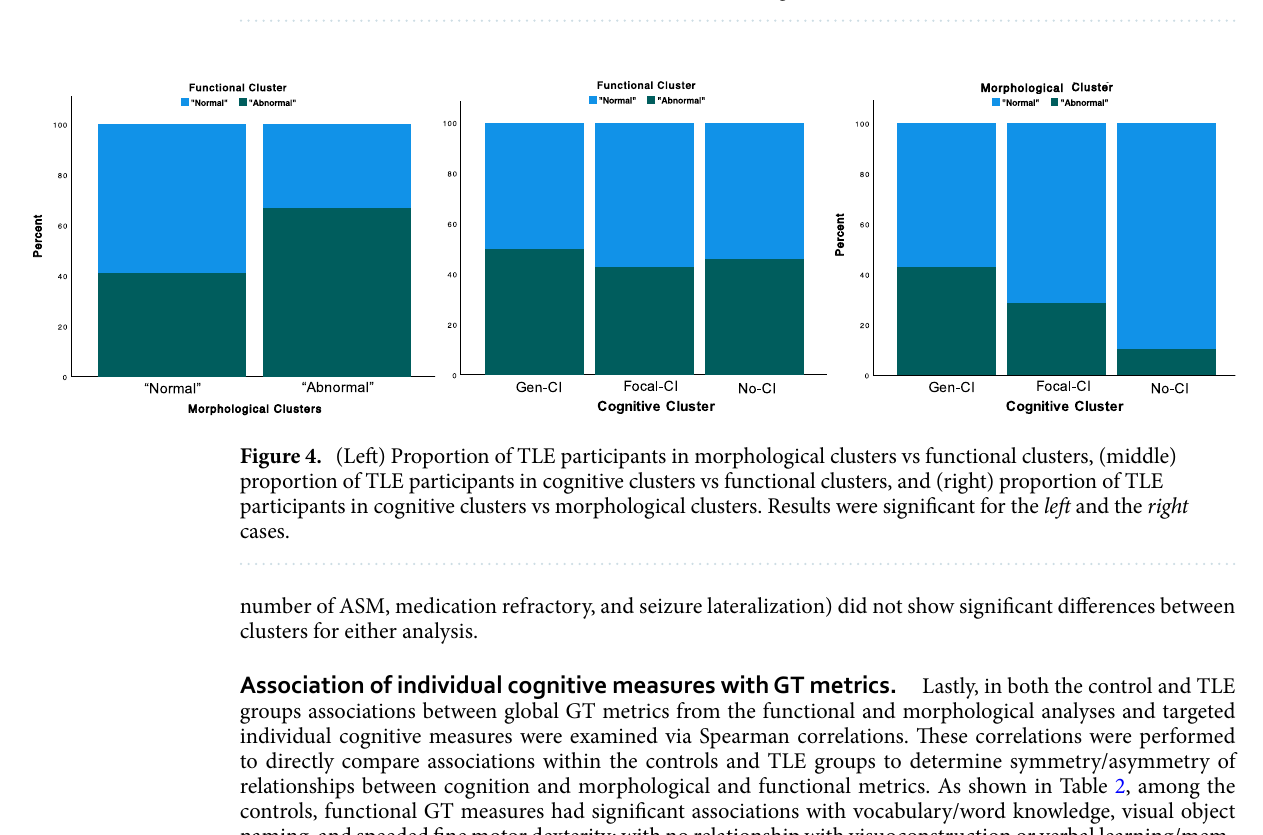
Figure 3. Adjacency matrices of functional (top) and morphological (bottom) correlation matrices on controls (left), “normal” clusters (middle), and “abnormal clusters” (right).